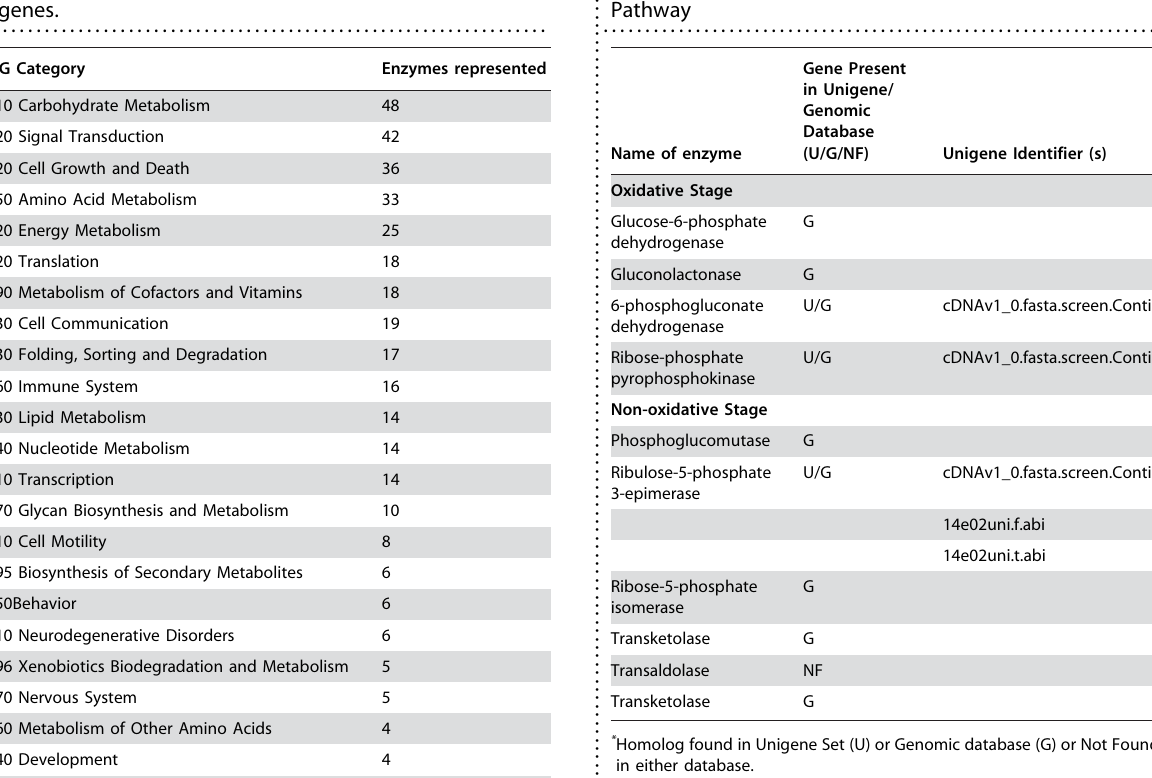
CIT1 (E.C.: 2.3.3.1) and CIT3 , that encode mitochondrial enzymes